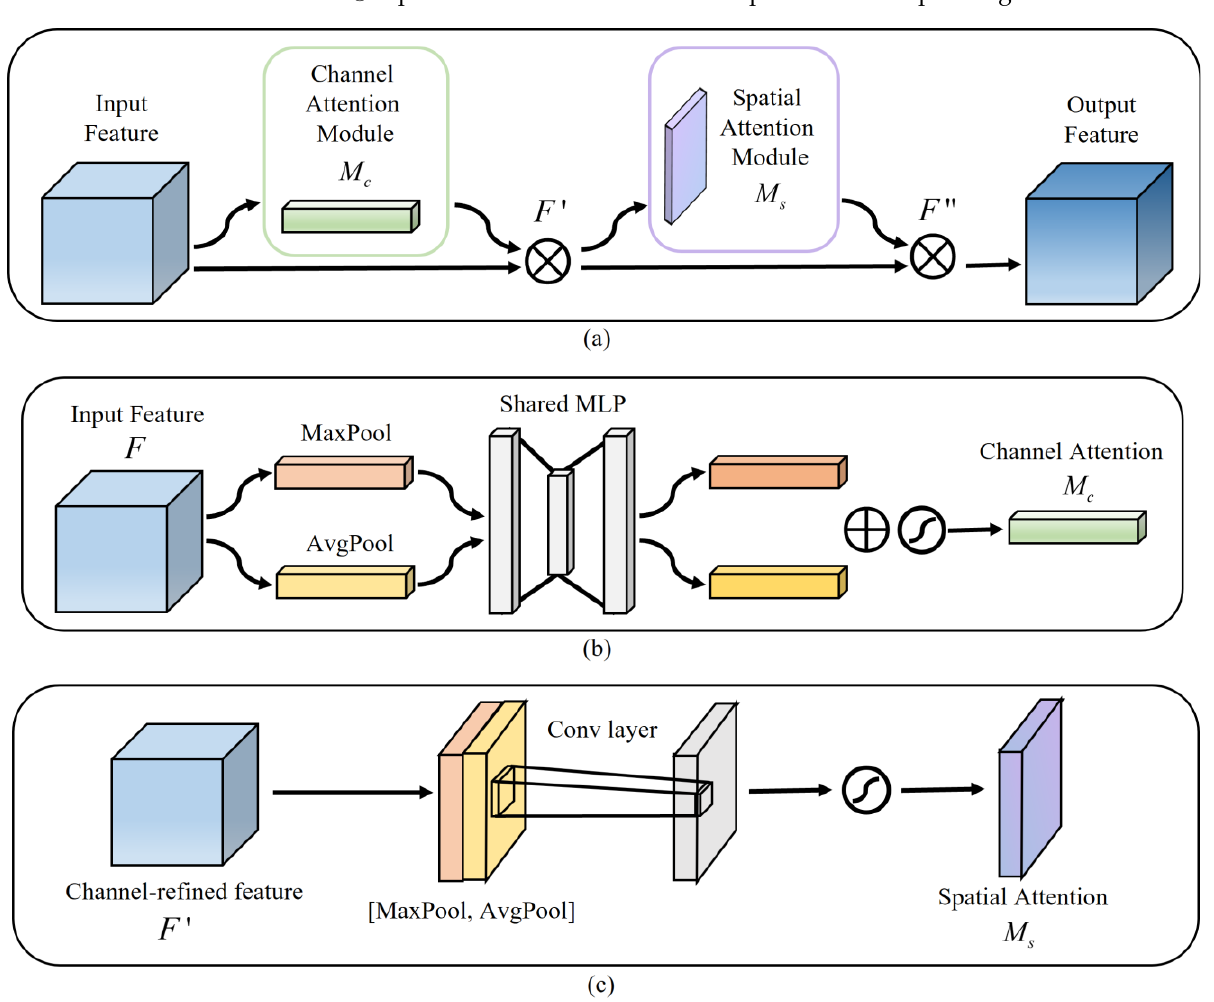
Figure 2. CBAM structure. ( a ) Convolutional Block Attention Module. ( b ) Channel Attention Module. ( c ) Spatial Attention Module.